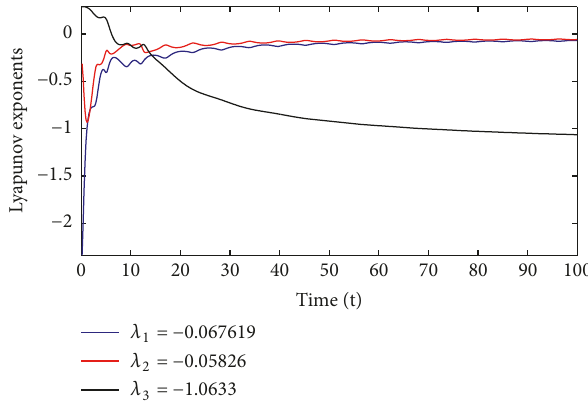
Figure 1: Lyapunov exponents for 𝜏 = 0 , depicting a stable